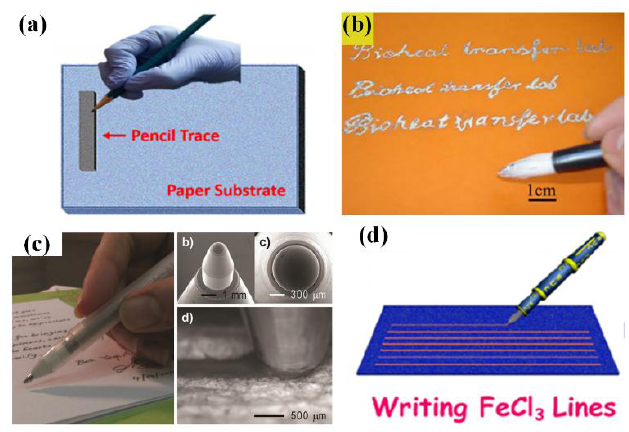
Figure 11. Directly writing electronics with different writing instruments: ( a ) Pencil; ( b ) Chinses brush pen; ( c ) Rollerball pen and ( d ) fountain pen. Reprinted from [133], with the permission of Elsevier. Reproduced from [189] with permission of WILEY. Reprinted with permission from [160], Copyright (2014) American Chemical Society.